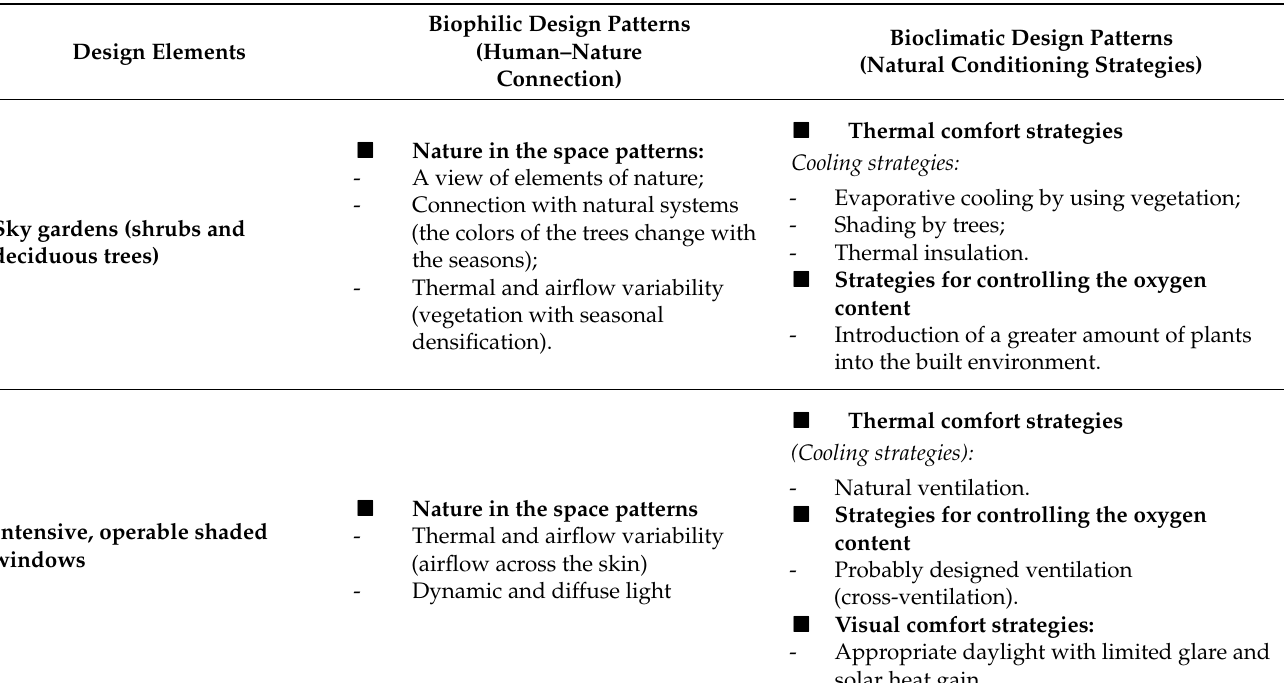
Table 6. The biophilic design strategies and patterns of Bosco Verticale